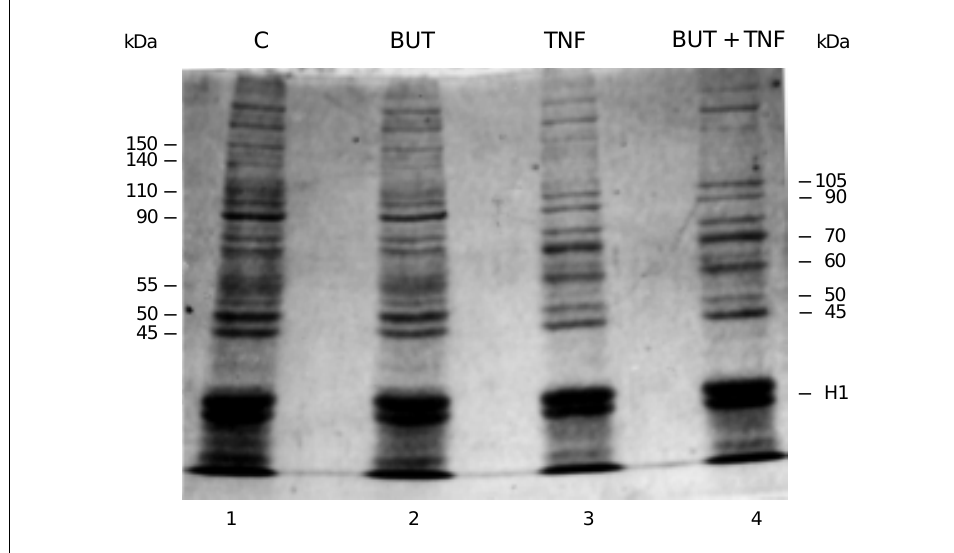
Figure 3 - Relative changes in cellular protein levels in the cell lysates from WEHI cells in the absence (C) and in the presence of 100 µM butyrolactone (BUT), in the presence of tumor necro- sis factor (TNF) (1 ng/ml), and of both butyrolactone and TNF af- ter 15 h of incubation. Equal a- mounts of proteins were sepa- rated by 10% SDS/PAGE, fixed and stained with Coomassie blue. The location and the appar- ent molecular mass of represen- tative protein bands are indi- cated on